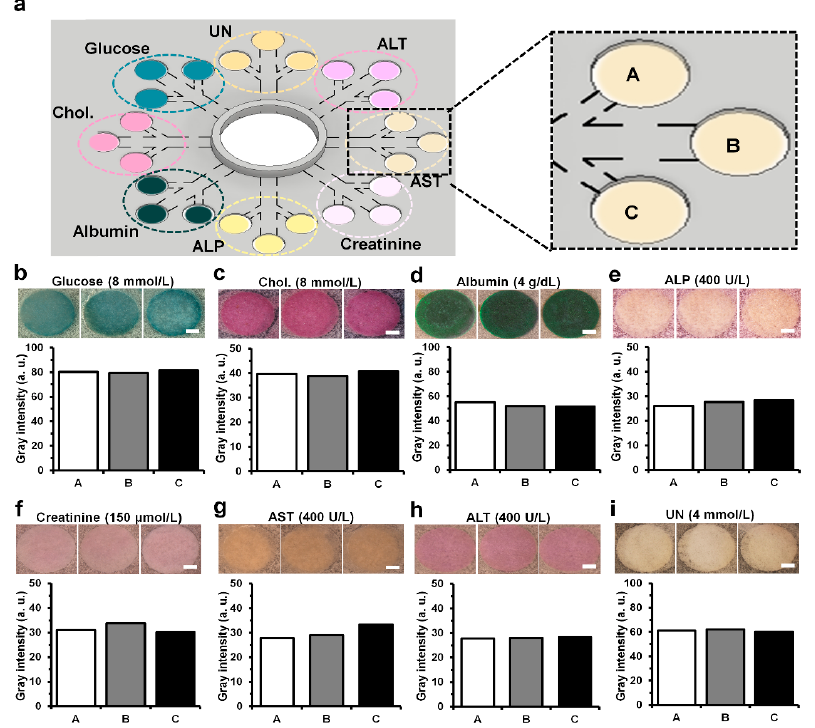
Figure 4. Uniformity comparison of colorimetric detection of eight biomarkers (glucose, cholesterol, albumin, ALP, creatinine, AST, ALT, and UN) at the concentration in PBS. ( a ) Schematics of the 3D- µ PADs for simultaneous detection of the eight biomarkers. The 3D- μ PADs have three detection zones (A, B, and C) per each biomarker. ( b – i ) Gray intensities calculated from the data obtained by three repeated uses of each analyte at the concentrations and representative images of the detection zones reacted with the concentrations of a single biomarker: glucose (8 mmol/L), cholesterol (8 mmol/L), albumin (4 g/dL), ALP (400 U/L), creatinine (150 μ mol/L), AST (400 U/L), ALT (400 U/L), and UN (4 mmol/L). (Scale bar: 1 mm. a.u.: arbitrary units. n = 3).